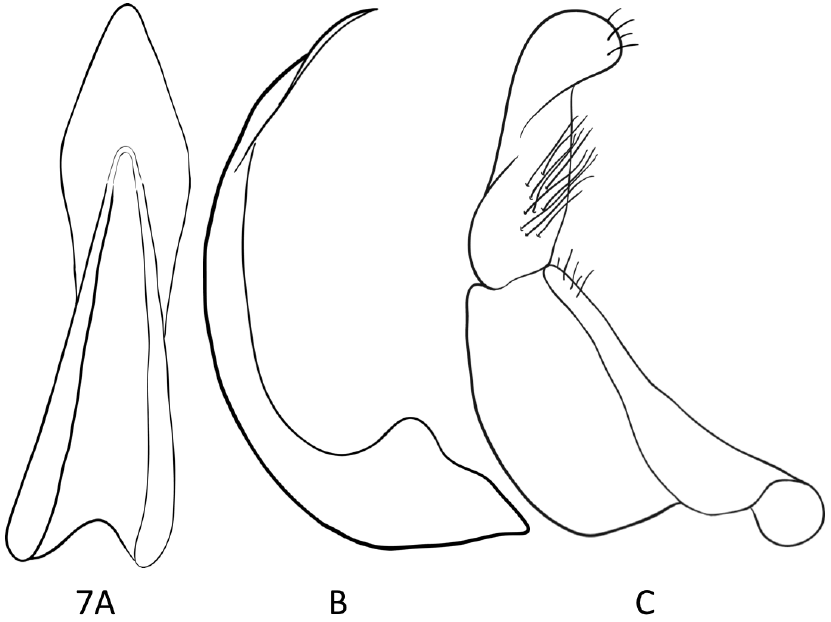
Figure 7. Leiodytes kualalipis sp. n., median lobe of aedeagus, ventral view ( A ), lateral view ( B ), para- mere, lateral view ( C